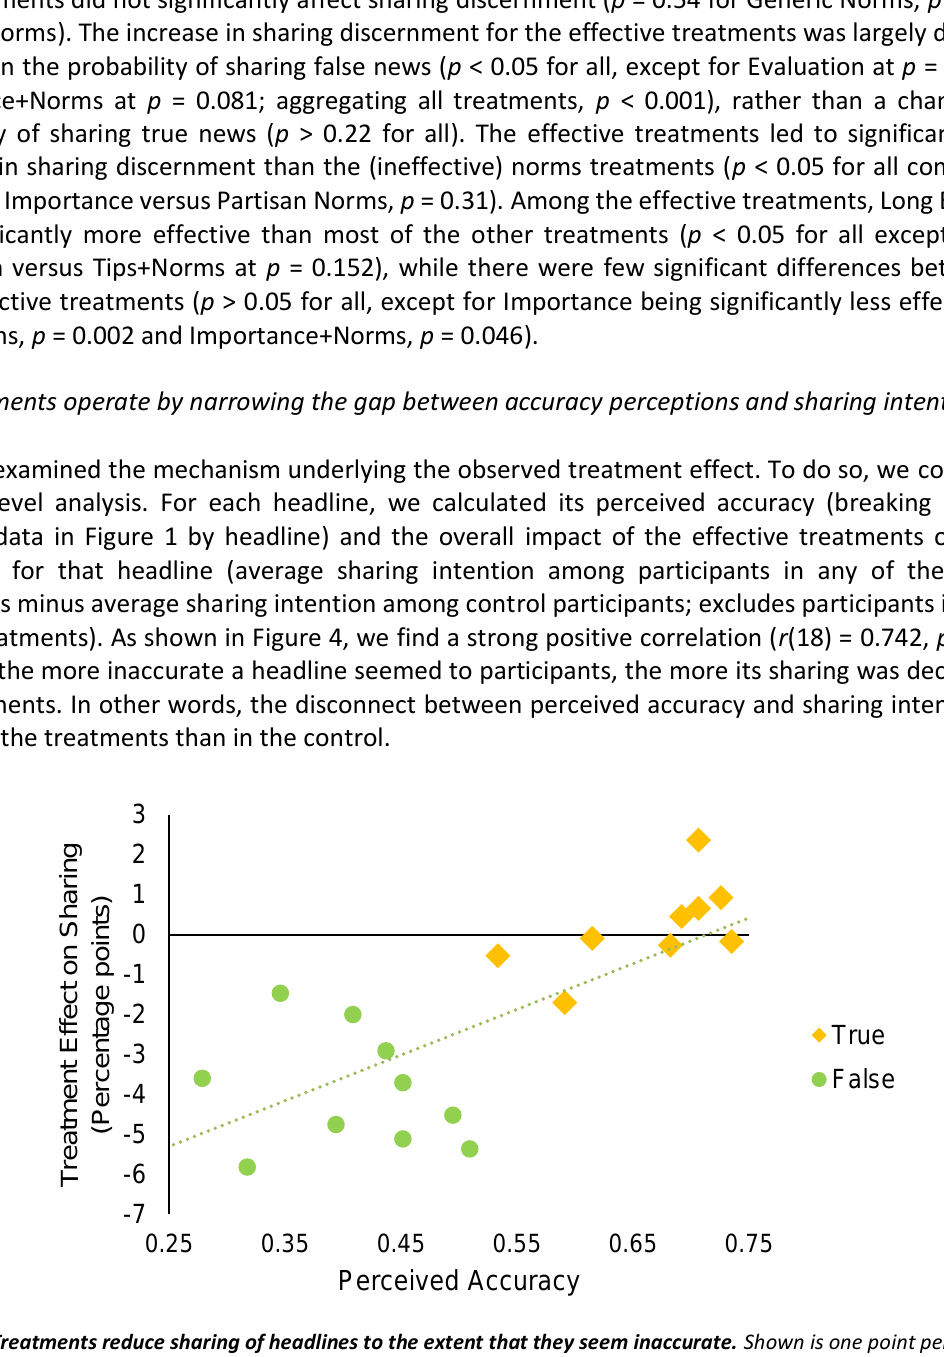
Figure 4. Treatments reduce sharing of headlines to the extent that they seem inaccurate. Shown is one point per headline, with perceived accuracy among participants in the Accuracy-Only condition on the x-axis, and average change in sharing intentions caused by the treatments on the